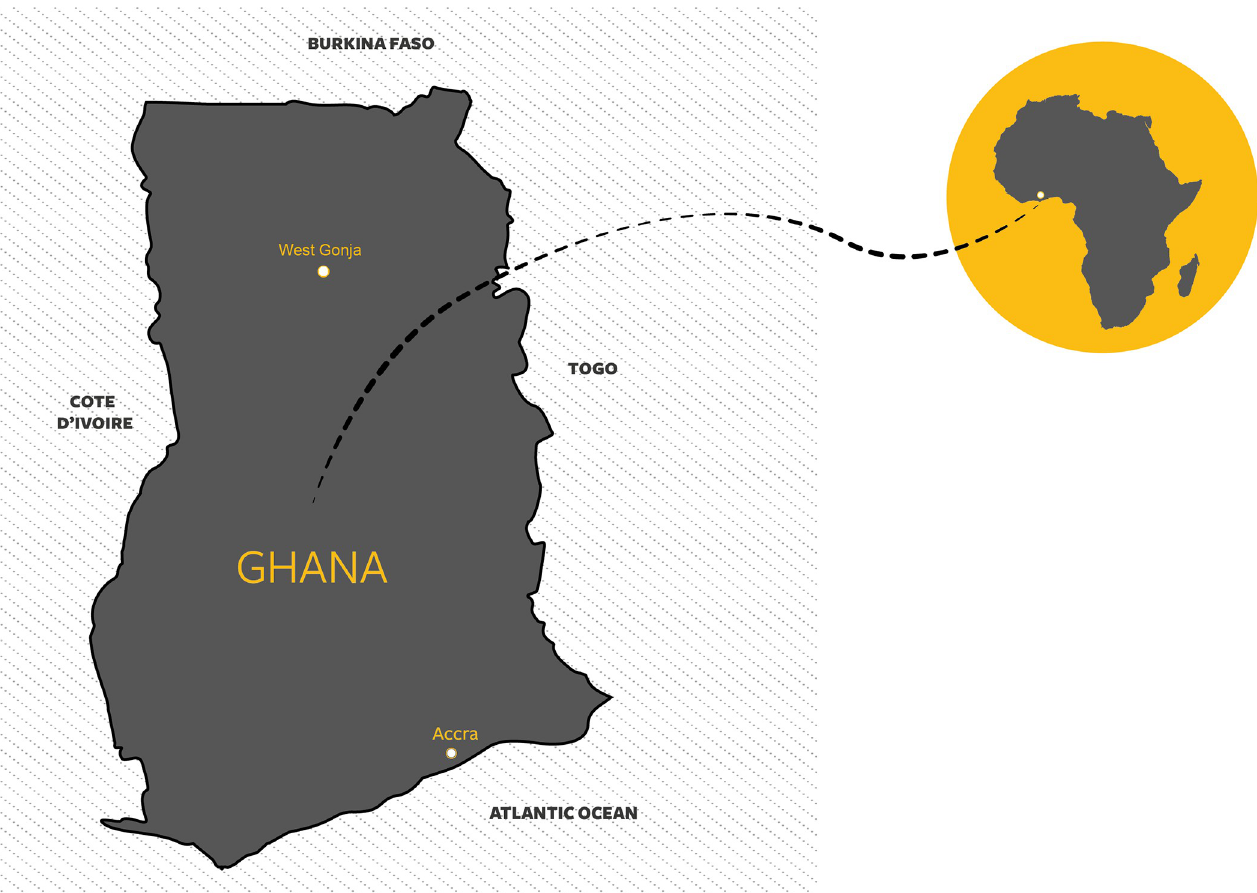
Fig 1. Map identifying the study location, West Gonja Municipal in Savanna Region of Ghana, West Africa. Image drawn within our research group, the Clinical Informatics Research Unit at University of Southampton.